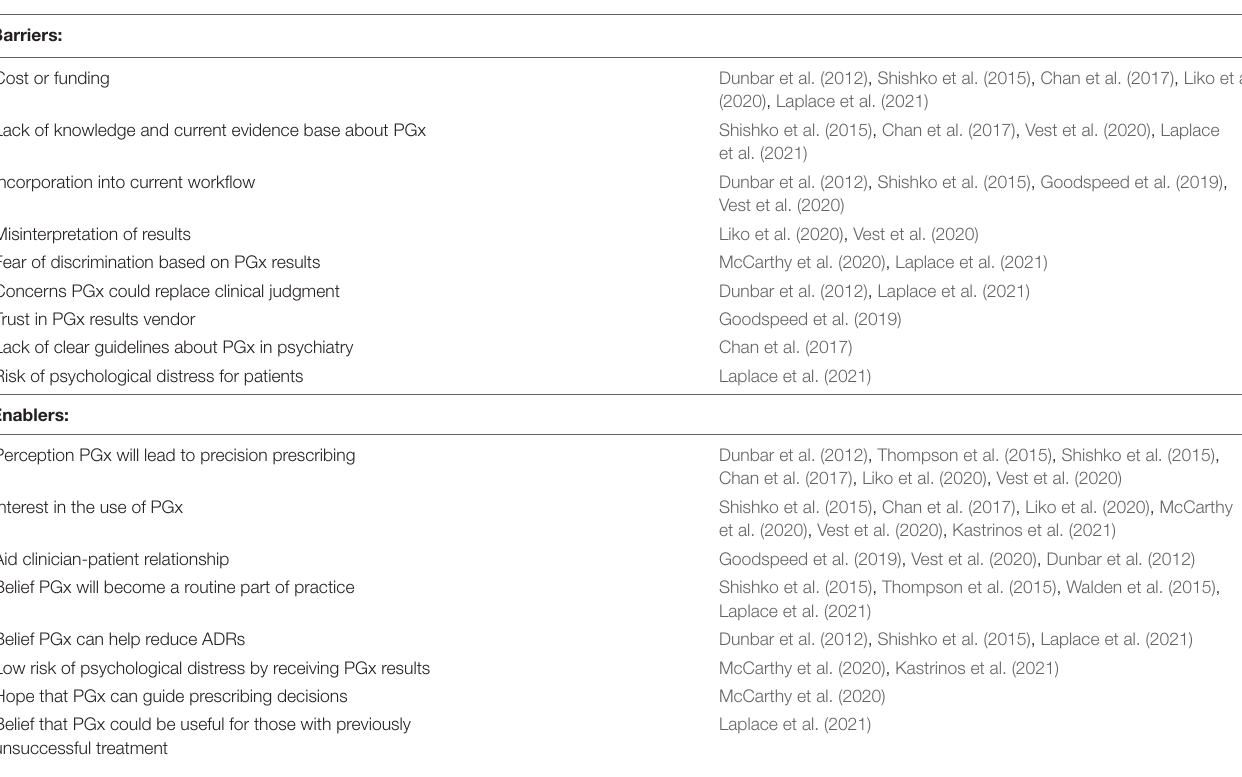
TABLE 1 | Summary of barriers and enablers extracted from each